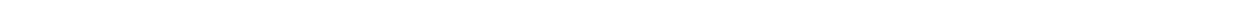
Fig. 4 Comparison of metaproteomic, shotgun metagenomic and 16S rRNA gene amplicon-based quanti fi cation of the mock communities. a The same mock communities as in Fig. 3 were used. For 16S rRNA gene amplicons and metaproteomes averages of four biological replicates per community type are shown. For the shotgun metagenomic data averages of three biological replicates are shown. For the metaproteomes the PSM-based quanti fi cation is shown (Fig. 3b). (gr − or gr + ) Gram-positive or -negative bacterium, (A) Archaeum, (E) Eukaryote, (V dsDNA, ssDNA or ssRNA) virus specifying nucleic acid type of genome. b – d Box plots show the x -fold deviation of the species abundance quanti fi cation with metaproteomics, metagenomics and 16S rRNA gene amplicon sequencing from the actual input amounts for protein ( b ) and ( c ), and cell number ( d ). c is an enlargement of the lower part of ( b ). If measured and input species abundance were equal, then all values would be exactly 0 (indicated by bright blue line). Zeros (species that were not detected i.e., ‘ ND ’ in a ) were removed before plotting. For each community type and method the method with the signi fi cantly lowest x -fold deviation (p- value < 0.01, t test) is indicated with a bright blue ‘ * ’ (see Supplementary Table 4 for details on statistics). NA species not added to this mock community, ND not detected with this